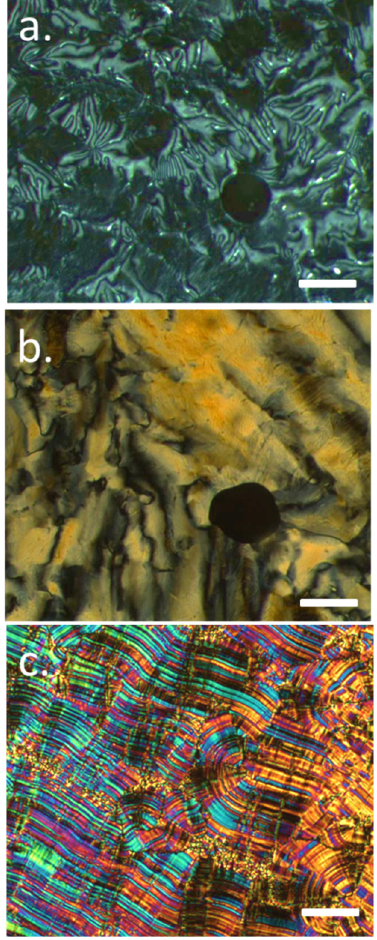
Figure 2. Photomicrographs of CB8OFFFT : ( a ) the schlieren texture of the SmC A phase at 85 °C; ( b ) a paramorphotic mosaic texture of the ‘X’ phase at 80 °C, note that this is the same region of the sample as shown in ( a ); ( c ) the banded fan texture of the ‘’X’’ phase at 79 °C. The scale bar corresponds to 50 μ m.